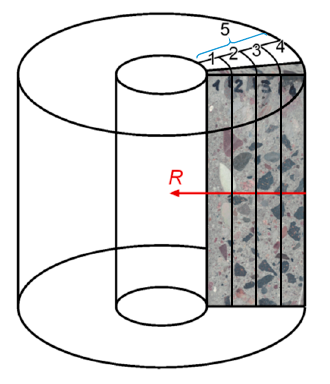
Figure 3. Sample shapes for laboratory tests.